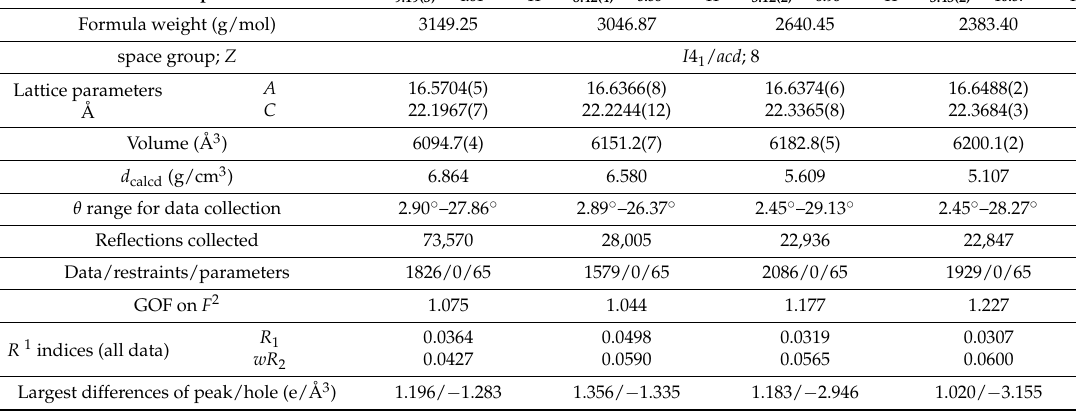
and (Sb 3 ) 7 − linear trimers are highlighted in green and blue, respectively. A unit cell is outlined in